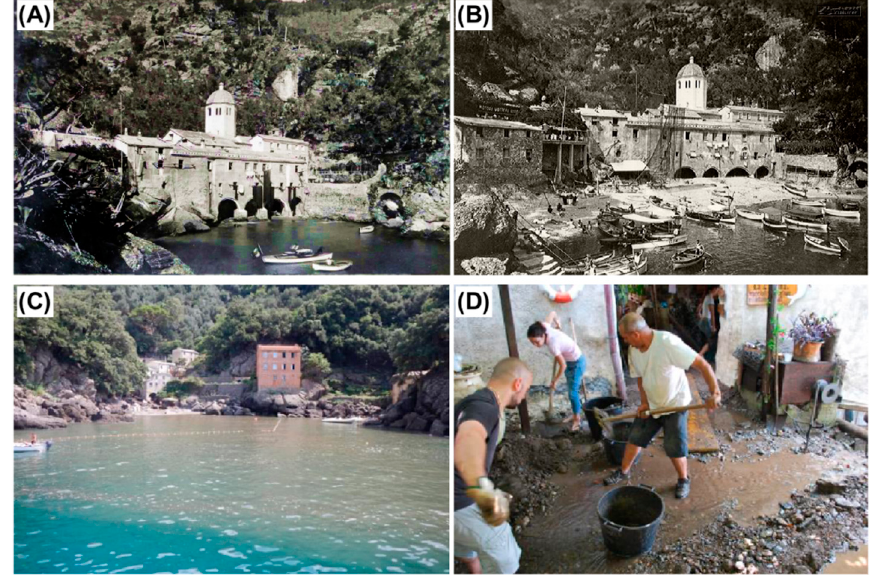
Figure 7. ( A ) San Fruttuoso bay and its hamlet in 1910 when the sea lapped against rocks and the ancient arcade (photo from the historical archive of Agenzia Bozzo, Camogli); ( B ) The new small beach in front of the abbey in 1920 generated by debris and materials carried downstream the Fontanini creek by running water during the damaging rainfall event on 25 September 1915 (photo from the historical archive of Agenzia Bozzo, Camogli); ( C ) Suspended sediment load inside the bay transported downstream the San Fruttuoso creek by intense and short-lived rainfall on 26 July 2014; ( D ) Damage to tourist structures and facilities in San Fruttuoso hamlet caused by the mud-debris flow occurred on 26 July 2014.